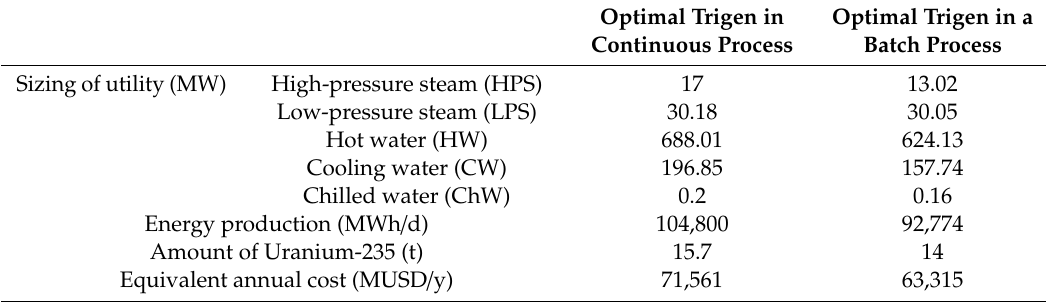
Table 12. Comparison of the optimal trigeneration system in continuous and batch processes